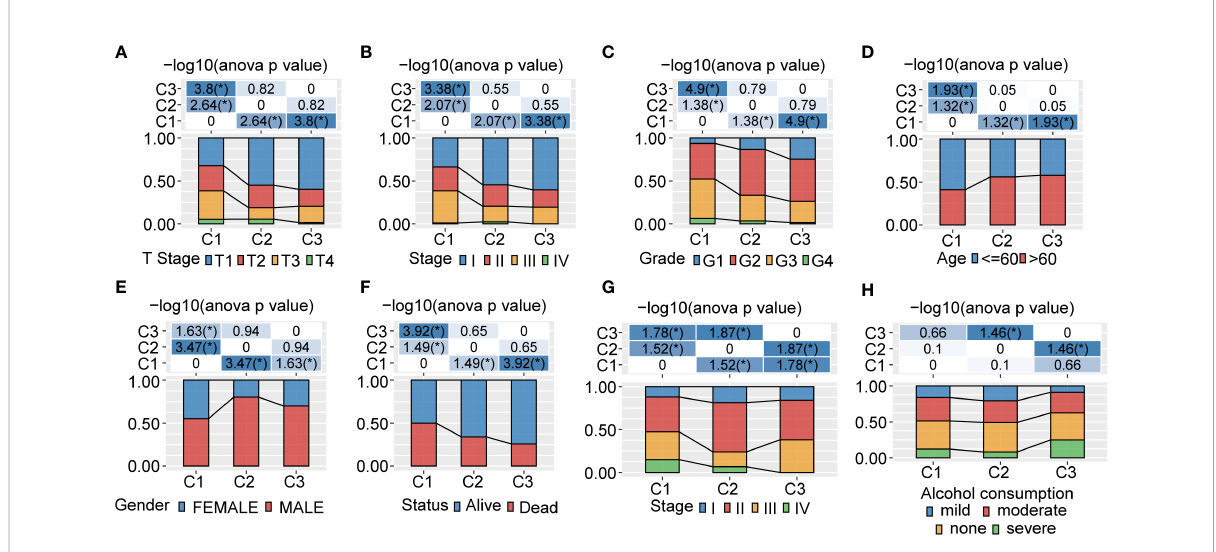
FIGURE 2 Clinicopathological characteristics between 3 clusters in the TCGA and ICGC cohorts (A − F) . Clinicopathological features between 3 clusters in the TCGA-LIHC cohort. The upper part of the tables represents the distribution difference between clusters. The lower part represents proportions. (G, H) . Clinicopathological characteristics of 3 clusters in the ICGC cohort. The upper part of the tables represents the distribution difference between clusters. The lower part represents proportions.